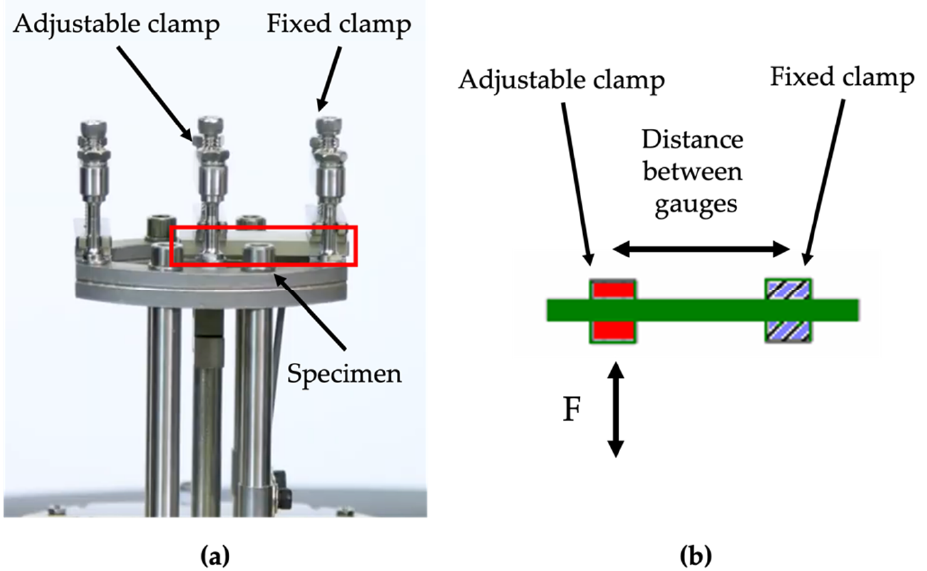
Figure 3. ( a ) Image of DMA single cantilever clamp. ( b ) Schematic of DMA single cantilever clamp.